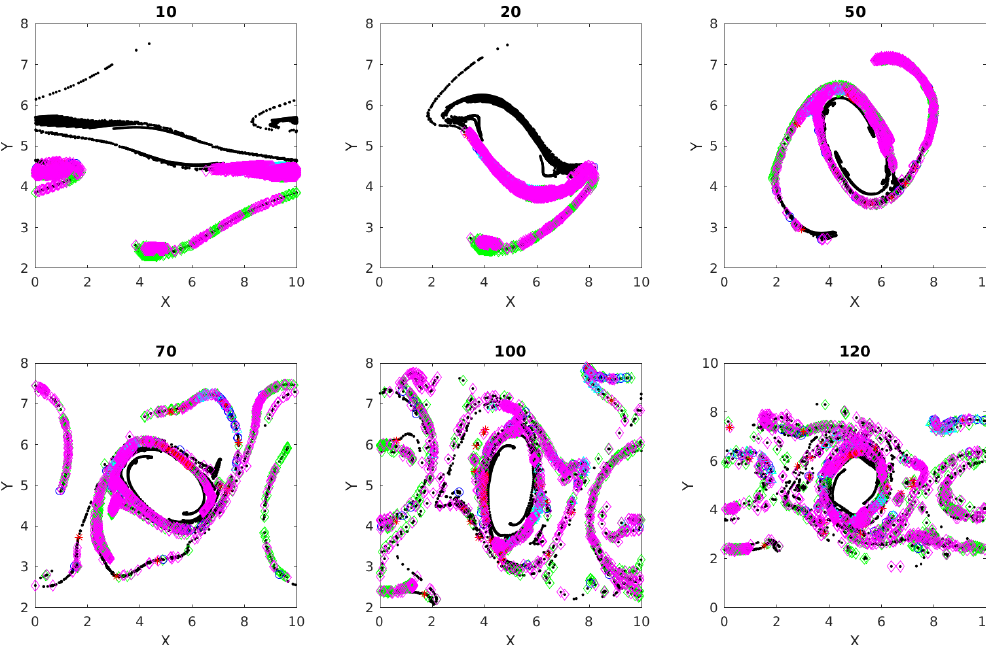
Figure 16. Spectral clusters in cluster 1 found at time 50 and tracked forward and backward.